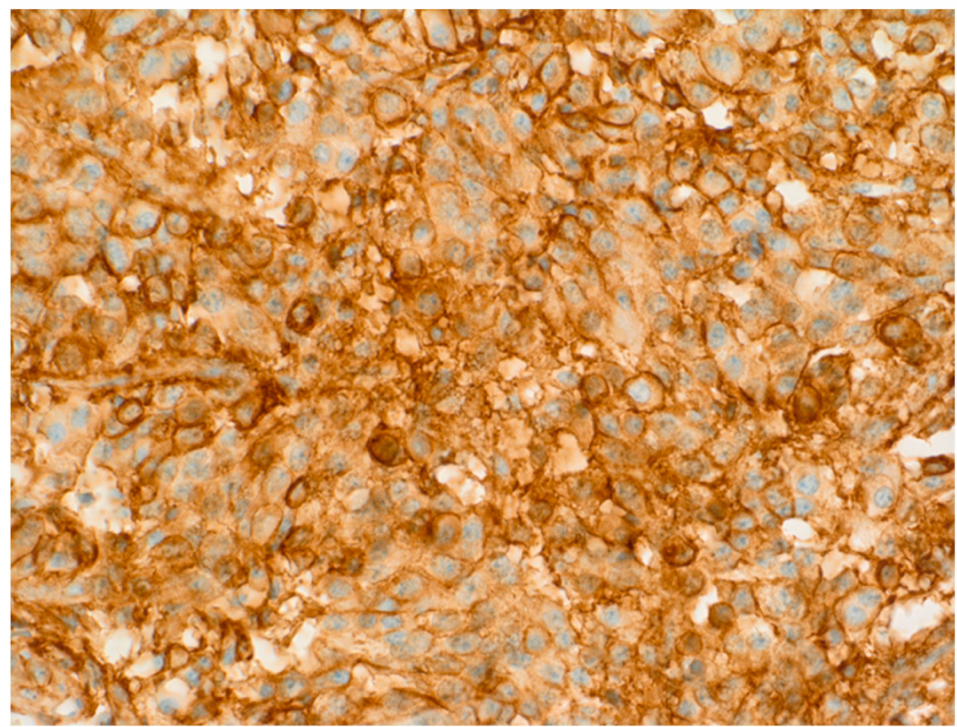
Figure 2. SSTR subtype 2 is present in >80% of the cells with moderate intensity of level 2; this leads to an immunoreactivity score (IRS) of 8 (patient 1).